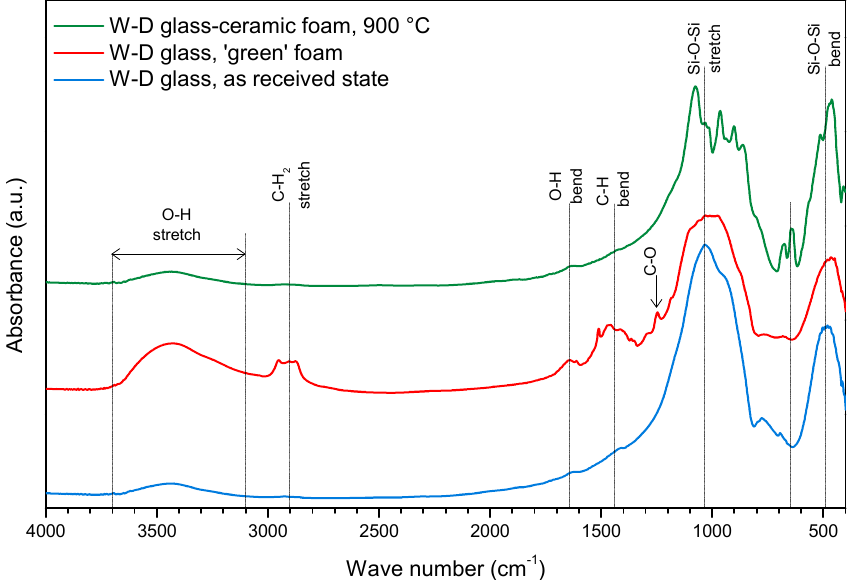
Figure 2. FTIR spectra of W-D glass, cured W-D glass foams, and W-D glass-ceramic foam after firing.